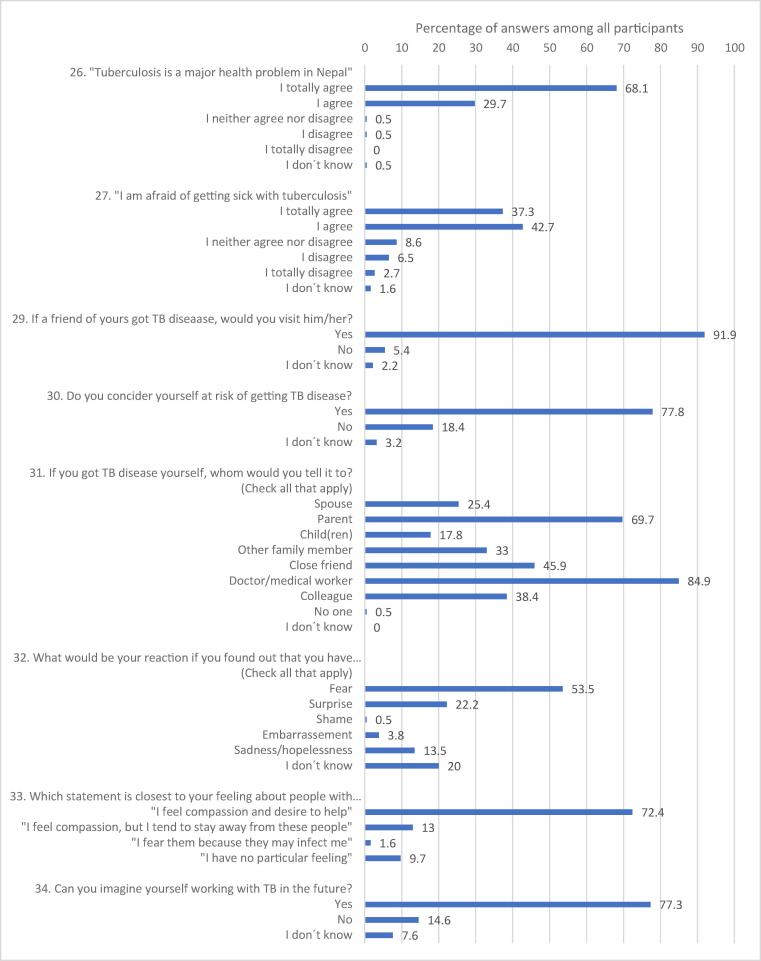
Distribution of answers on attitude questions.